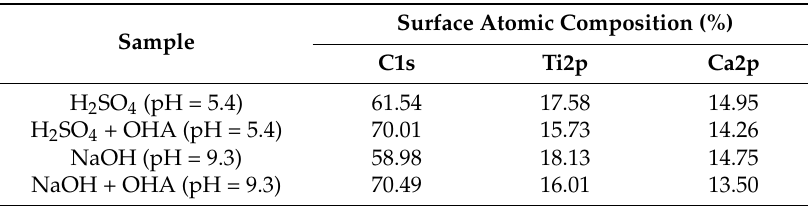
Table 3. Relative contents of elements on perovskite surface.